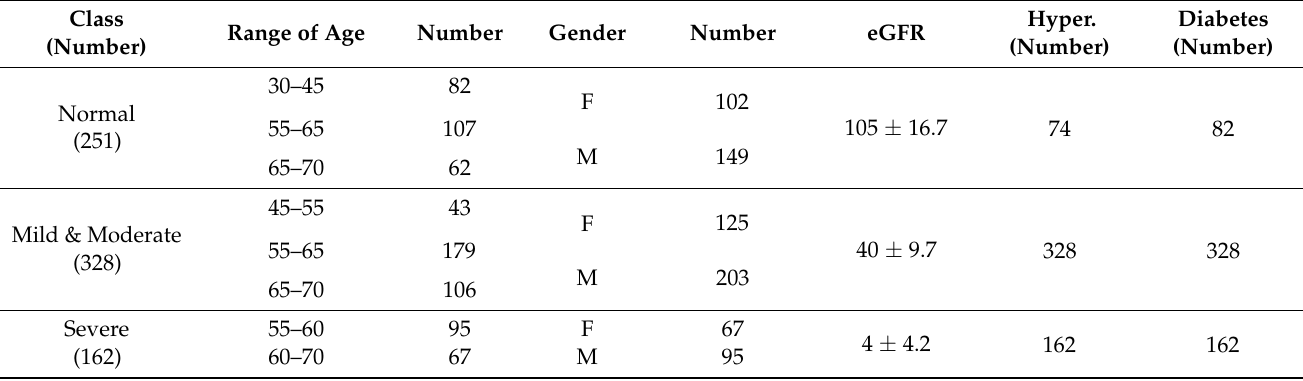
Table 1. Clinical characteristics.